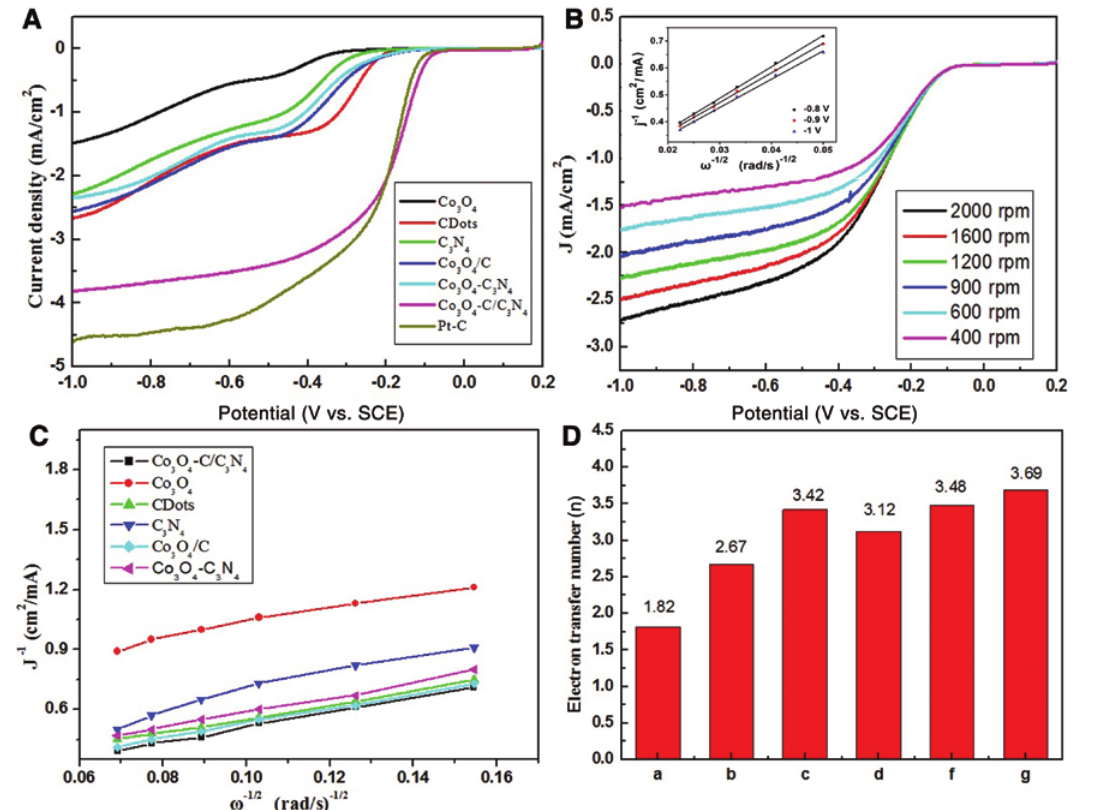
O , carbon nanodots [CDots], C 3 4 O -C N ; f: Co O -C; and g: Co 3 4 3 4 3 4